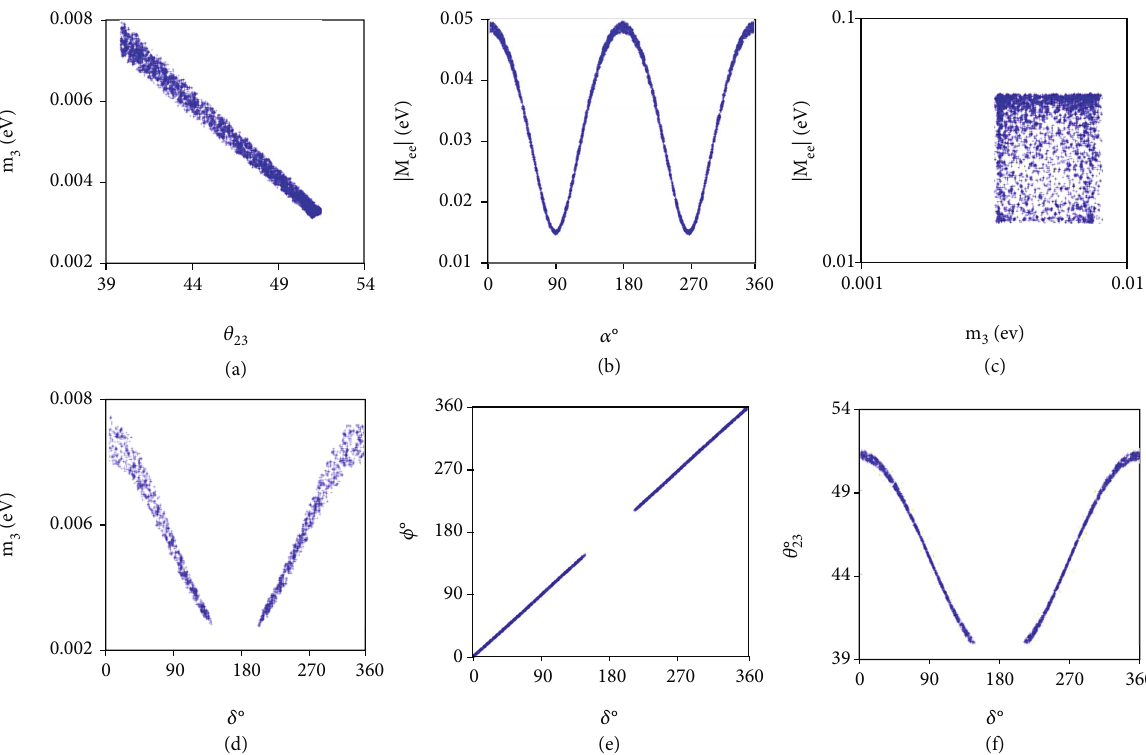
Figure 2: Correlation plots among various parameters for textures (a) M 4